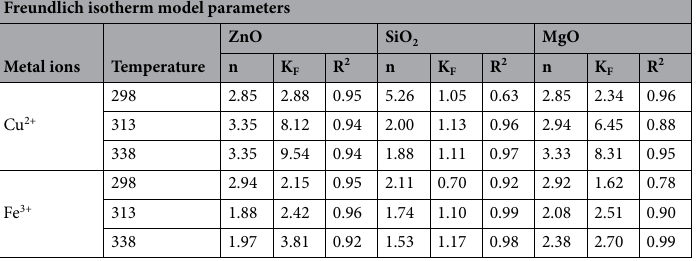
Table 2. Freundlich isotherm model parameters and correlation coefficients for the adsorption of Cu 2+ and Fe 3+ ions on ZnO, SiO 2 , and MgO